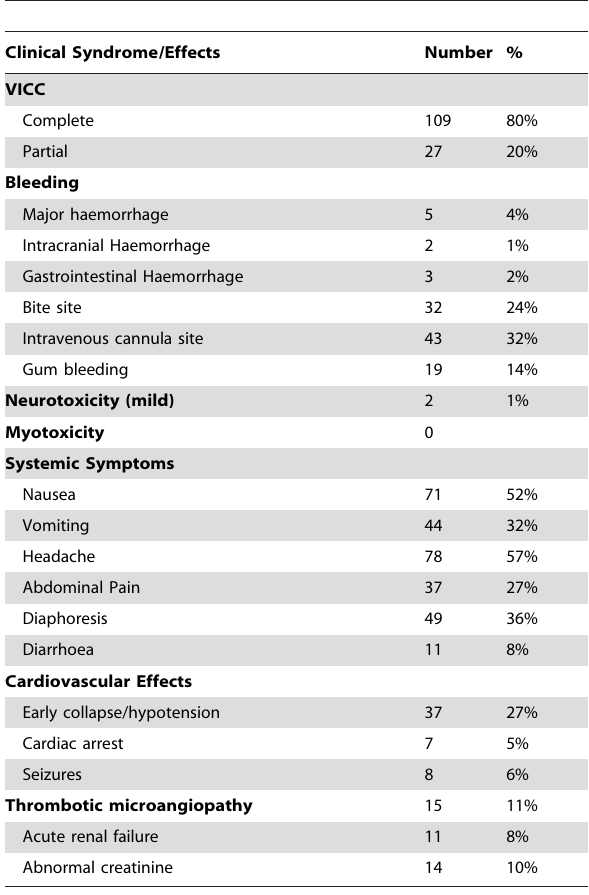
Table 2. Clinical features of the 136 patients with definite brown snake envenoming.